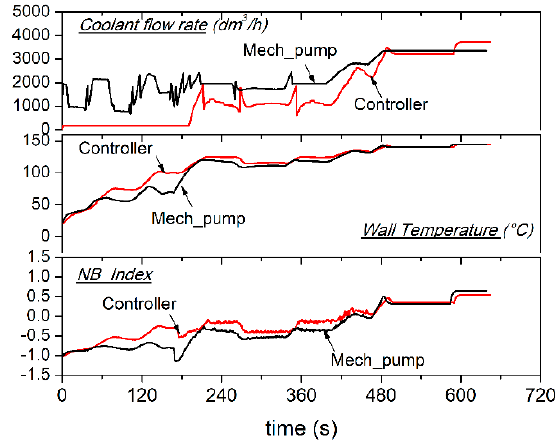
Figure 24. Controlled coolant flow rate ( top ), average wall temperature ( middle ), and NB_Index ( bottom ) for prolonged high load operation ( m(cid:4662) (cid:2916) = 9 kg/h).